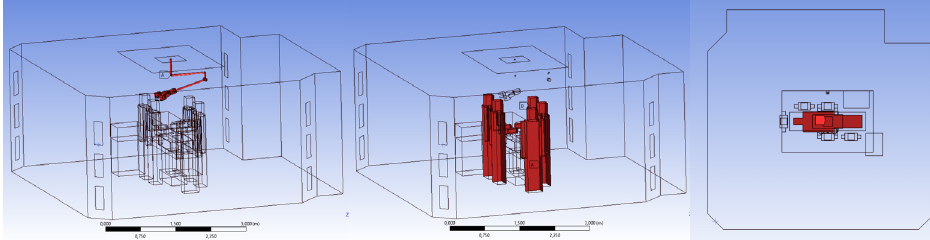
Figure 1. Position of the lamp, staff, and patient in the CFD simulation of the operating room.